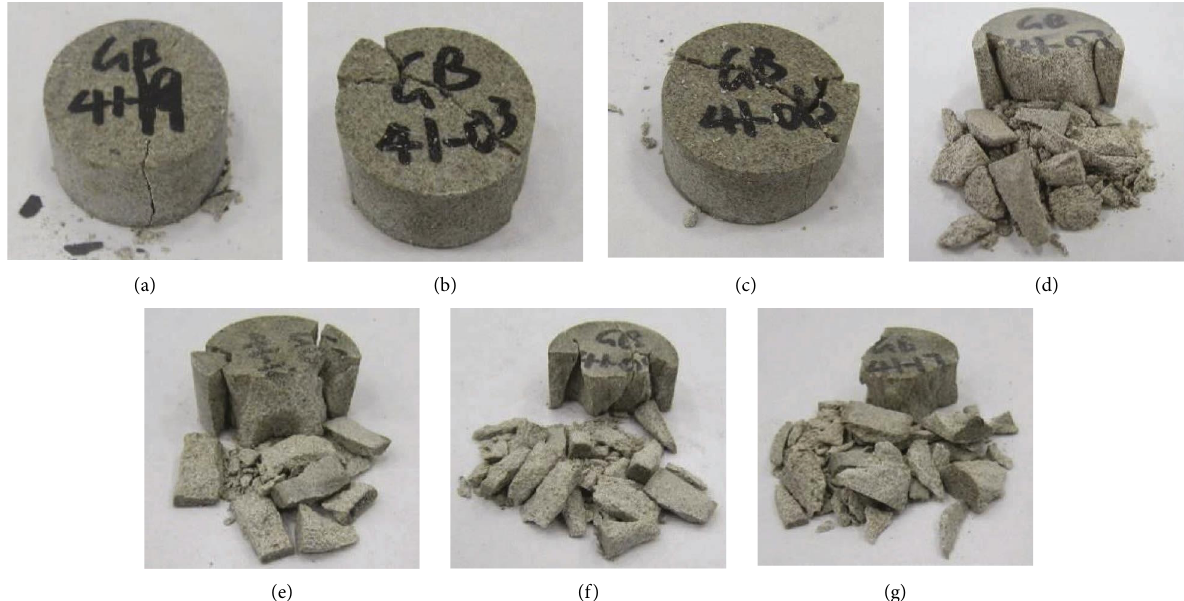
Figure 11: Impact damage forms of sandstone corroded by different pH solutions. (a) Uncorroded. (b) pH � 7. (c) pH � 8. (d) pH � 9. (e) pH � 10. (f) pH � 11. (g) pH �